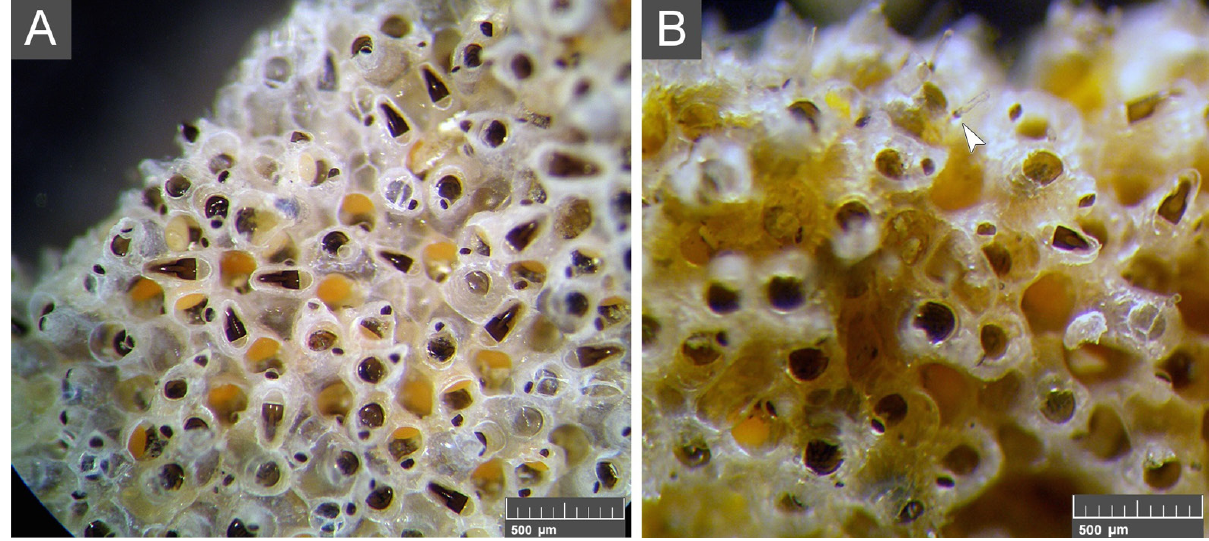
Fig. 3. – A, B. Celleporaria brunnea from the western Mediterranean Sea, showing opercula, sclerites of avicularia mandibles, base of spines (see arrow) and lophophore tentacles, dark brown in colour.